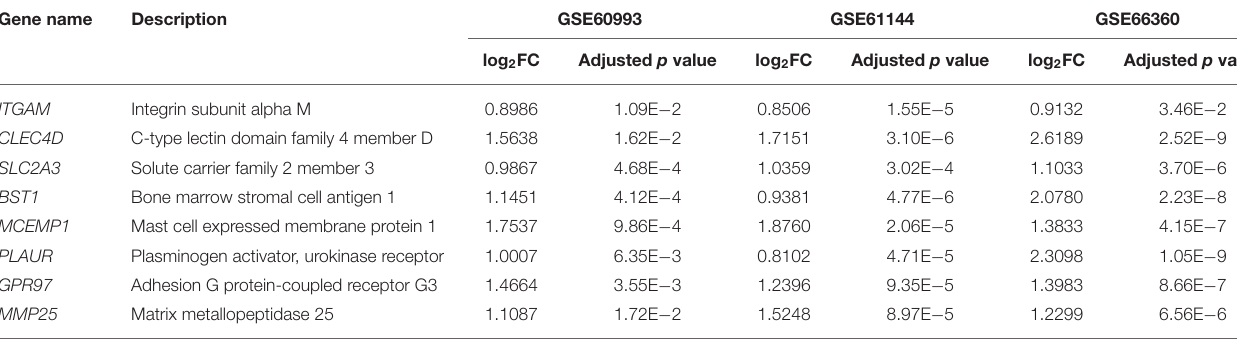
TABLE 2 | Detailed information of the hub genes.